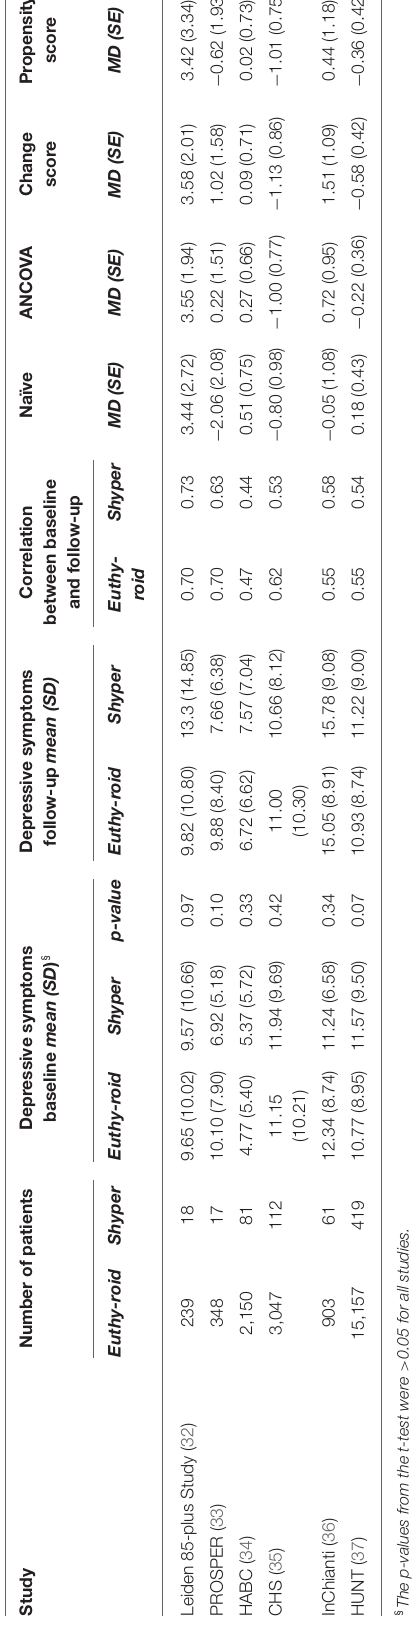
( Table 4 ). At the meta-analytic level, in the fixed effects